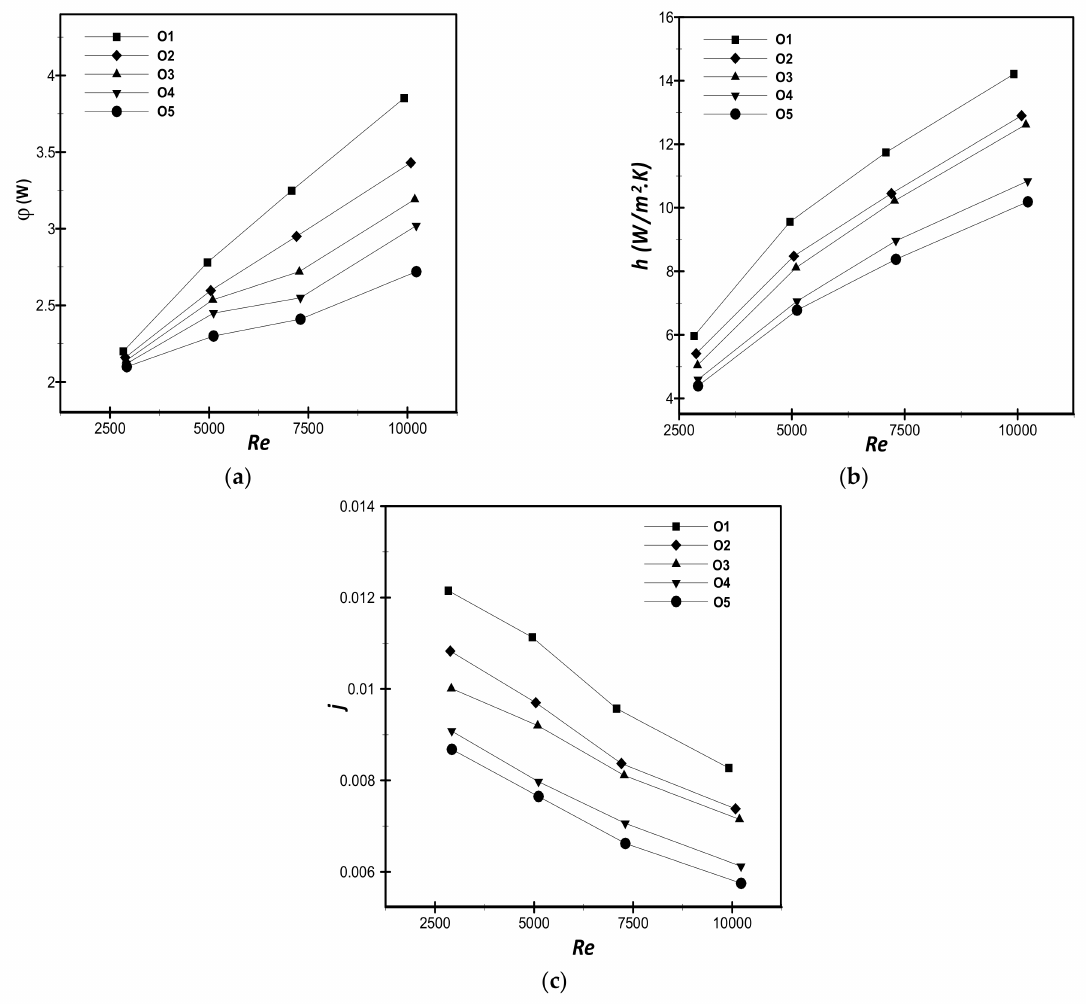
Figure 8. Comparison of oval tube shapes at varying Res: ( a ) thermal exchange rate, ( b ) convective heat transfer coefficient, and ( c ) Colburn